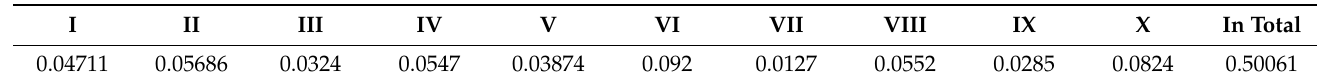
Table A1. Results by items (first area).